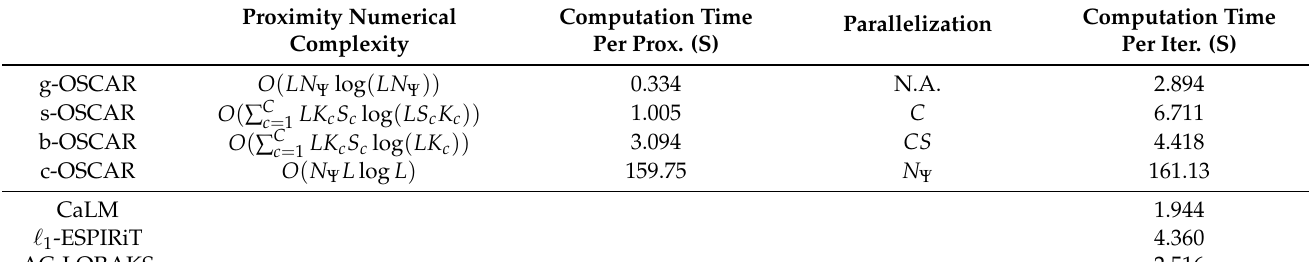
Table 1. Numerical complexity and parallelization capacity of OSCAR-norm regularizations using Daub. 4 OWT and ( N , C , L ) = ( 640 320,4,16 ) for MRI reconstruction. The computation times of other state of art methods (CaLM, (cid:96) 1 -ESPIRiT × and AC-LORAKS) are also mentioned